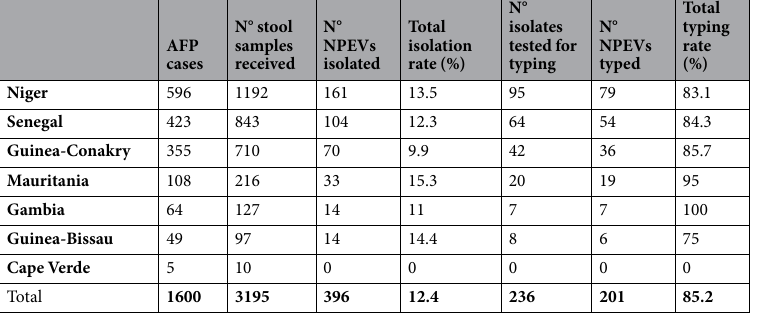
Table 1. Frequency of AFP cases, NPEVs isolated, NPEVs typed, isolation rate and typing rate, West Africa,